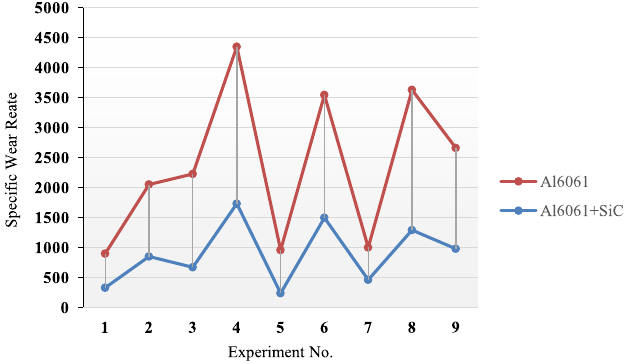
Fig. 5. Comparison of speci fi c wear rate of Al6061 and Al6061+ SiC.